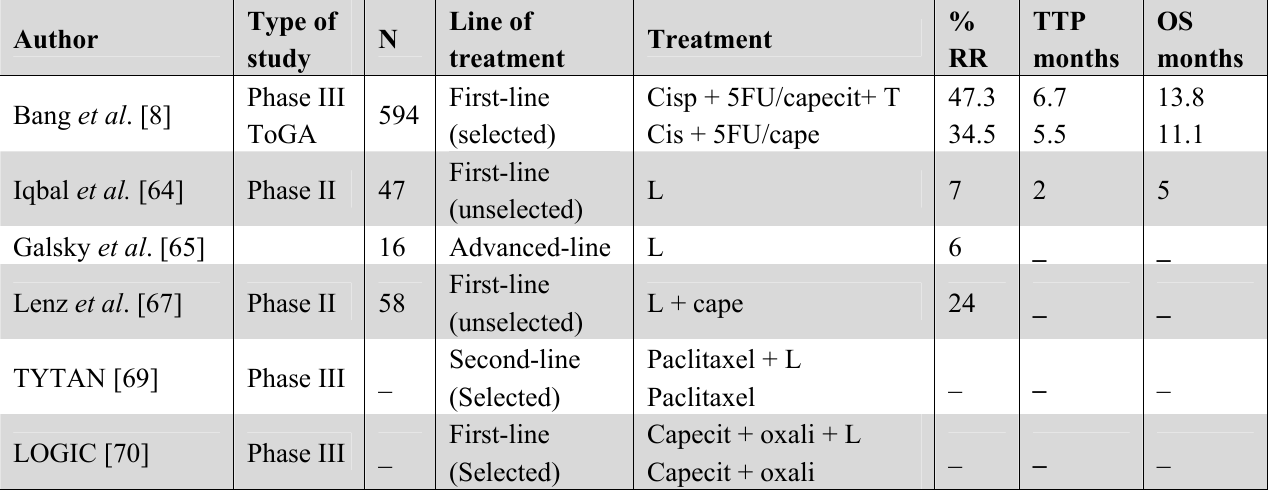
Table 4. Clinical trials with anti-HER-2 agents: T and